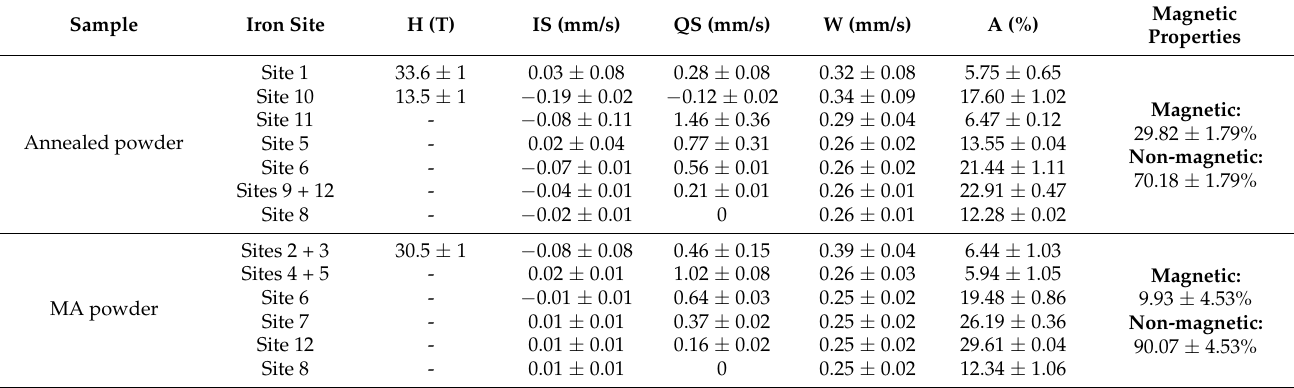
Figure 2. Mössbauer spectra of MA and annealed powder: ( a ) main spectra; ( b ) zoomed central part of the spectra. Table 1. Mössbauer hyperfine parameters, such as the hyperfine field (H), isomer shift (IS), quadrupole splitting (QS), peak width (W), and relative amount of each iron environment (A) of iron environments in the mechanically alloyed powder and annealed powder.